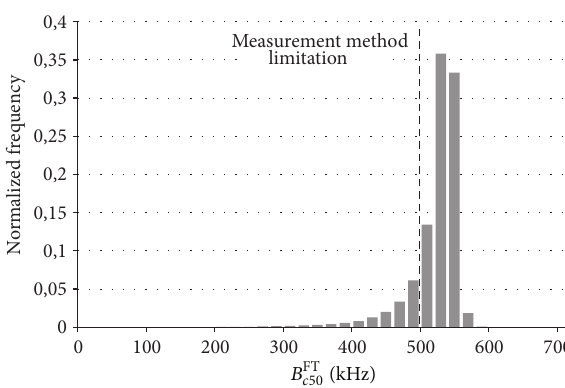
Figure 19: Histogram of coherence bandwidth values estimated from Fourier transform of PDP for correlation level 0.5 in flat terrain.